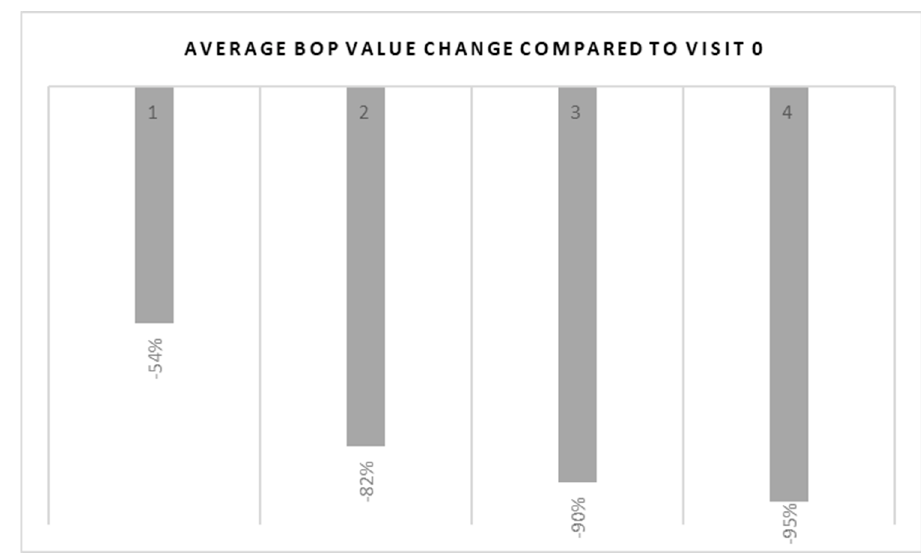
Figure 3. Graphical analysis of BOP decline in comparison to visit 0.